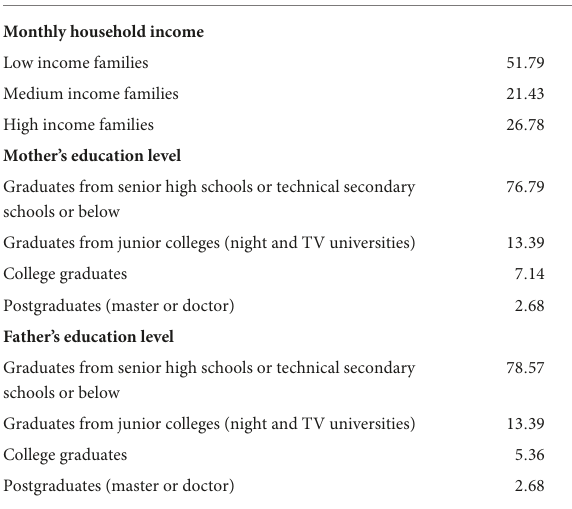
TABLE 1 Subjects’ family SES